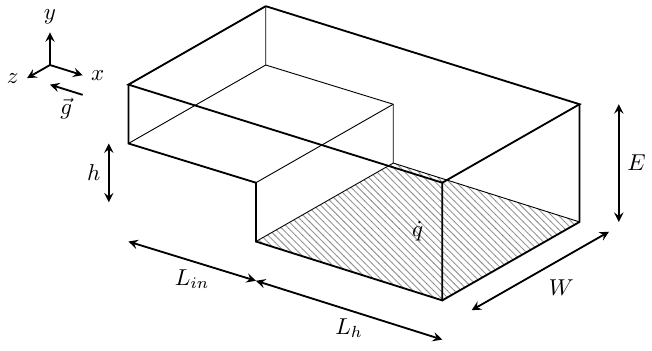
Figure 7. Backward-facing step geometry. Table 3. Backward facing step: Geometrical parameters of the simulated